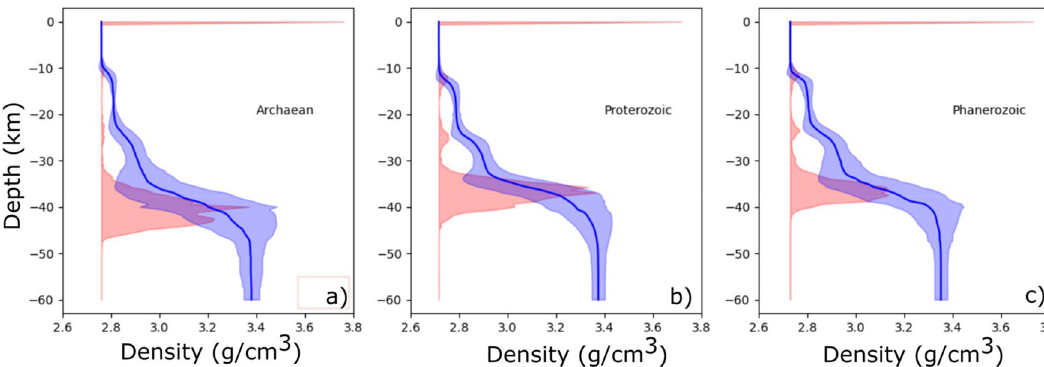
Figure 4. Crustal density models (blue, ± 1SD) for averaged ( a ) Archaean, ( b ) Proterozoic and ( c ) Phanerozoic crust, from the CRUST1.0 seismic model. Red indicates the distribution of melt, calculated using a Monte Carlo approach from the melt densities shown in Fig. 3C.